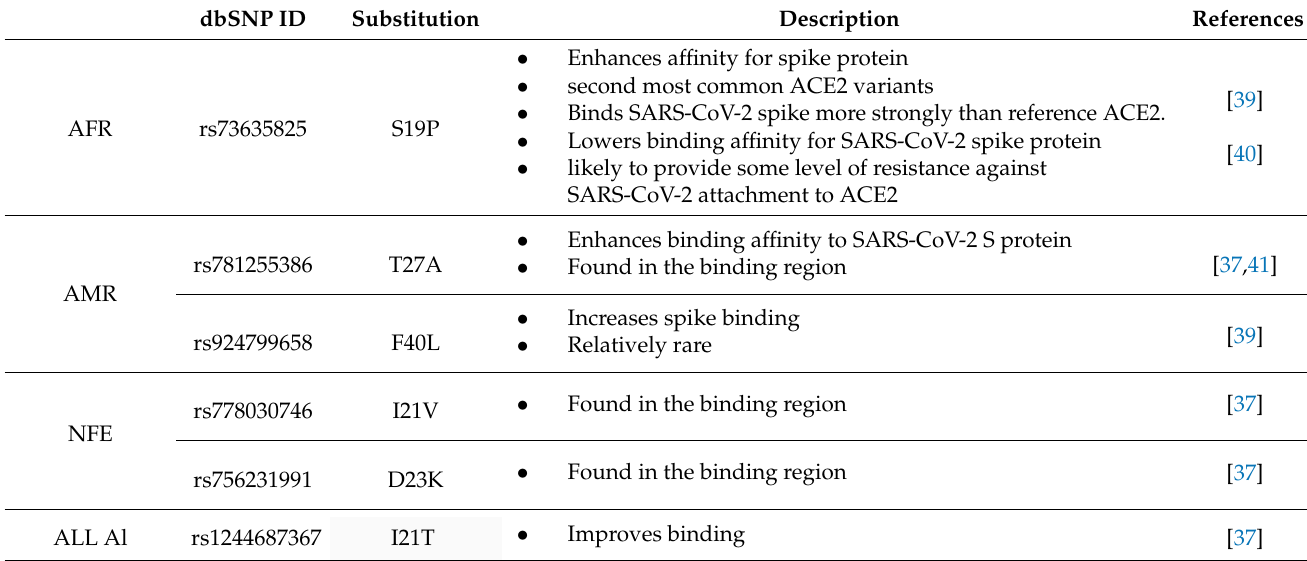
Table 1. ACE2 variants: interindividual variability in different populations.